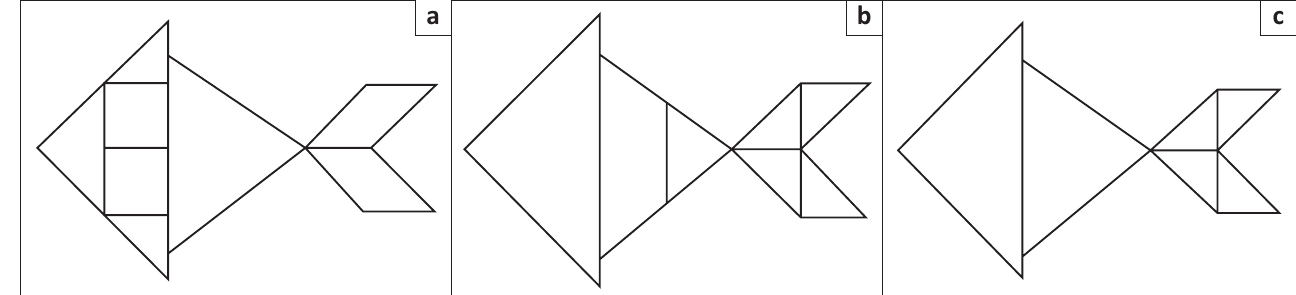
FIGURE 2: Example of different patterns of fish and embedding shapes in the first demo lesson.